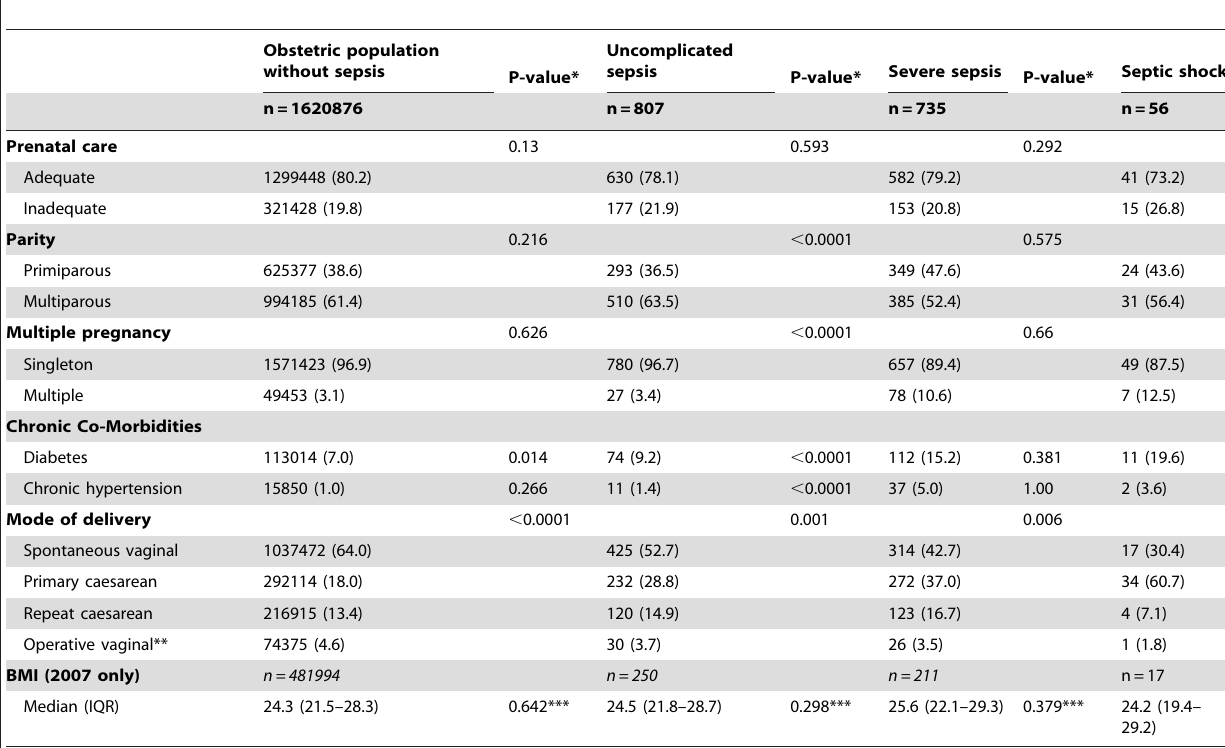
Table 2. Clinical characteristics of non-sepsis obstetric population compared to women with uncomplicated sepsis, compared to severe sepsis, compared to septic shock in California